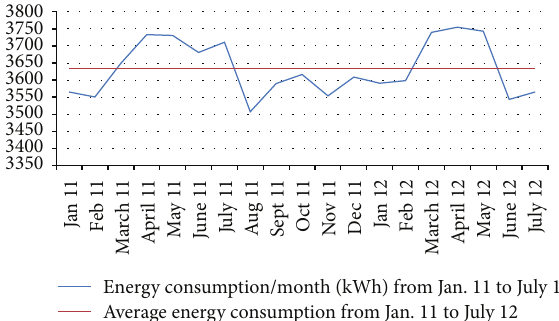
Figure 5: Monthly energy consumption curve, Missinguileo site from January 11 to July 12.